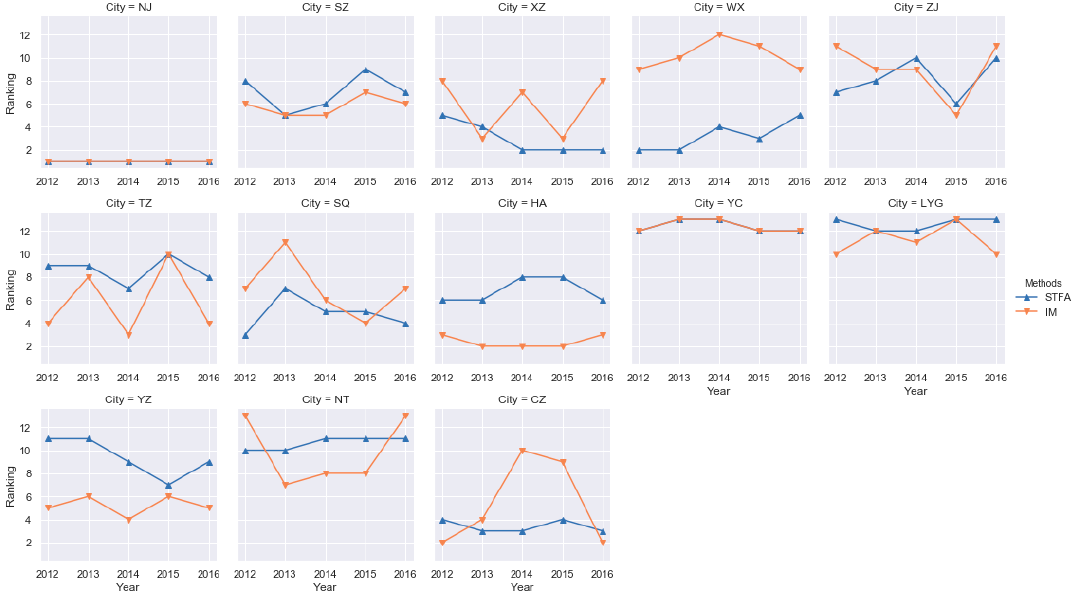
Figure 4. Comparison of the results through STFA and Incidence Matrix.